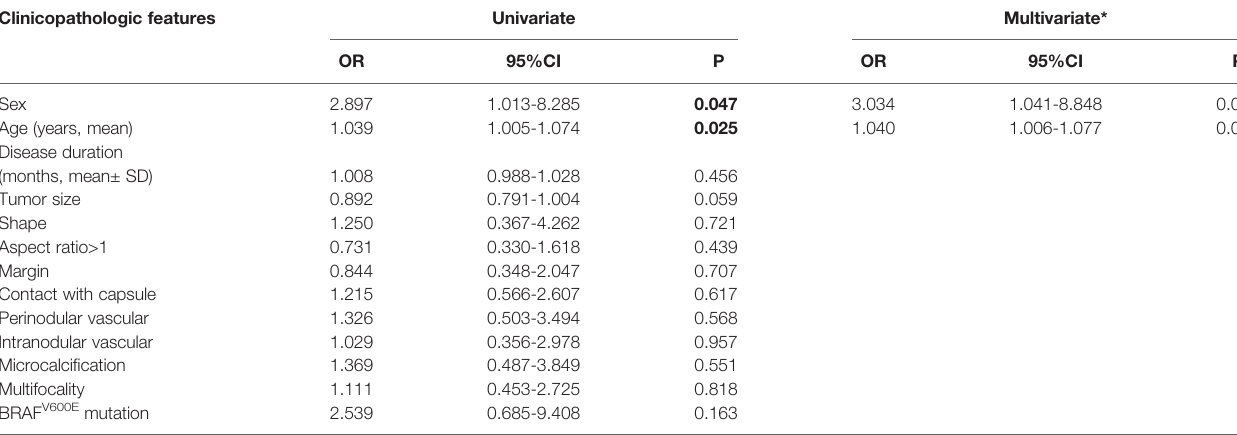
TABLE 5 | Univariate and multivariate analyses to compare the high-risk factors of CLNM in PTC